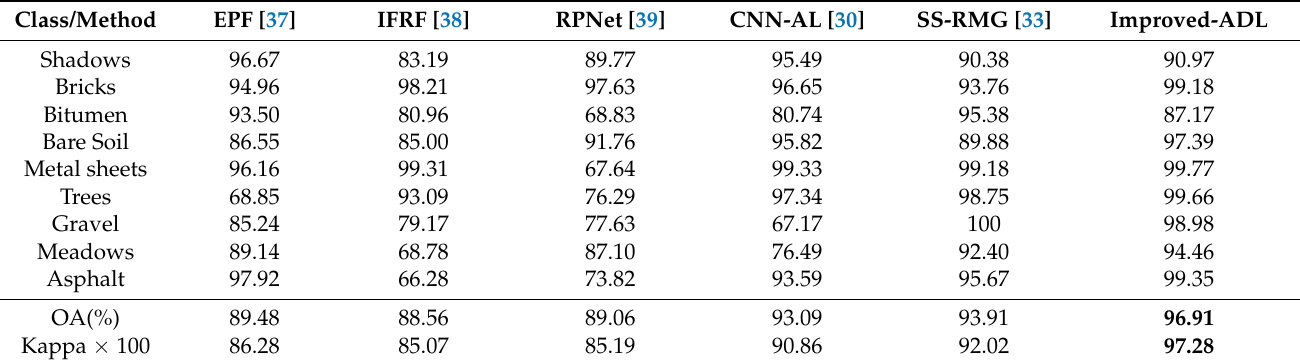
Table 7. Classification results of different methods on the Pavia University